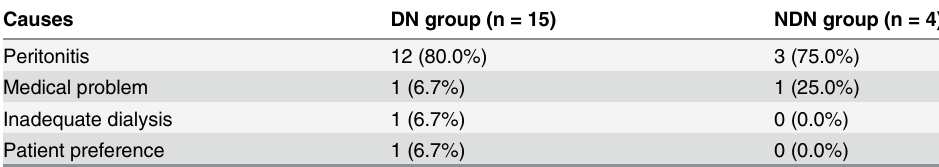
Table 6. Causes of transferring to HD in DN group and NDN group.